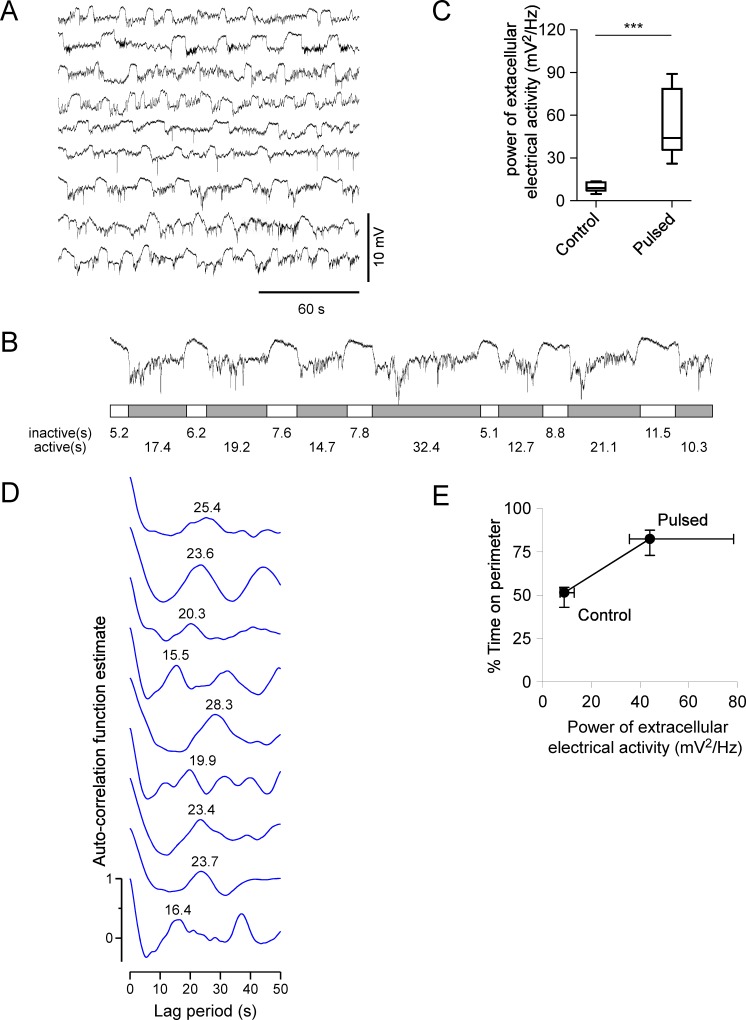
Pulsed light stimulation increased struggling activity of w1118 male flies.(A) Extracellular recordings from w1118 flies subjected to pulsed light stimulation for entire life cycle and 4 additional days since emergence. (B) Demonstration of the time duration calculation of inactive and active phases of the pulsed w1118 flies. The time duration of inactive or active phases were calculated with Clampfit 10 software (Molecular Devices). To calculate the total inactive (active) time duration, the inactive (active) time periods are summed. (C) Plot of power (mV2/Hz) vs control (n = 8) and pulsed (n = 9) w1118 flies. Asterisks (* or ***) indicate P < 0.05 or P < 0.001 by Kruskal-Wallis test. (D) Auto-correlation analysis of periodicities in pulsed flies. Values are the periodicity estimates for most recordings. (E) Correlation analysis between % TOP and power of struggling activity in control (n = 8 for both % TOP and power analysis) and pulsed (n = 8 for % TOP and n = 9 for power analysis) w1118 flies. Black dots and error bars indicate median, 25% and 75% percentile of values.